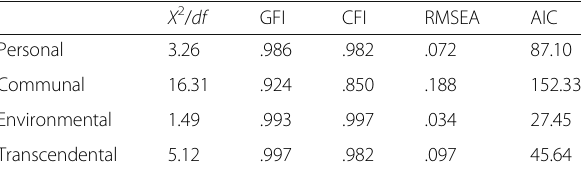
Table 1 Absolute goodness-of-fit indices for the SWBQ b factors in the calibration sample ( N =